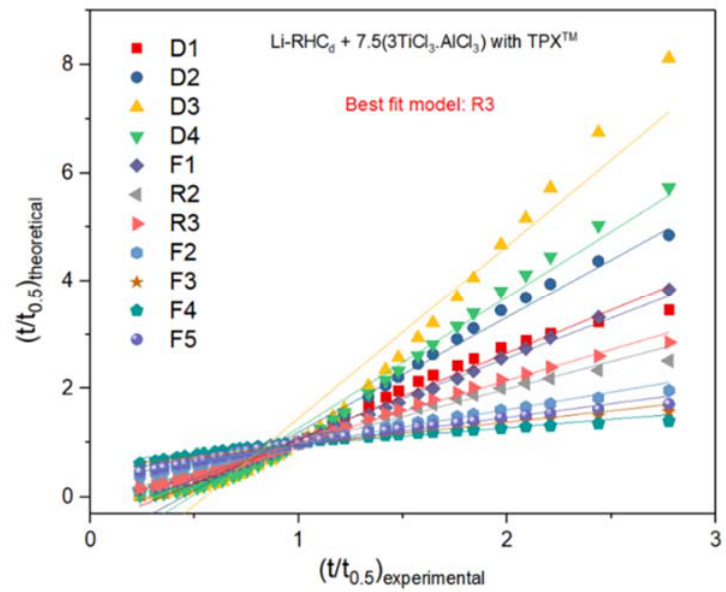
Figure 9. (t / t 0.5 ) experimental vs. (t / t 0.5 ) theoretical plots for Li-RHC d + 7.5(3TiCl 3 · AlCl 3 ) with TPX TM at the 2nd hydrogenation at 400 ◦ C and under 50 bar of H 2 . The method assumes that the most suitable reaction model provides a linear fitting with R 2 close to 1 and a slope of about 1. Table 3. Fitting parameters extracted from corresponding applied models (referred to Figure 9). Fraction from 0.10 to 0.93